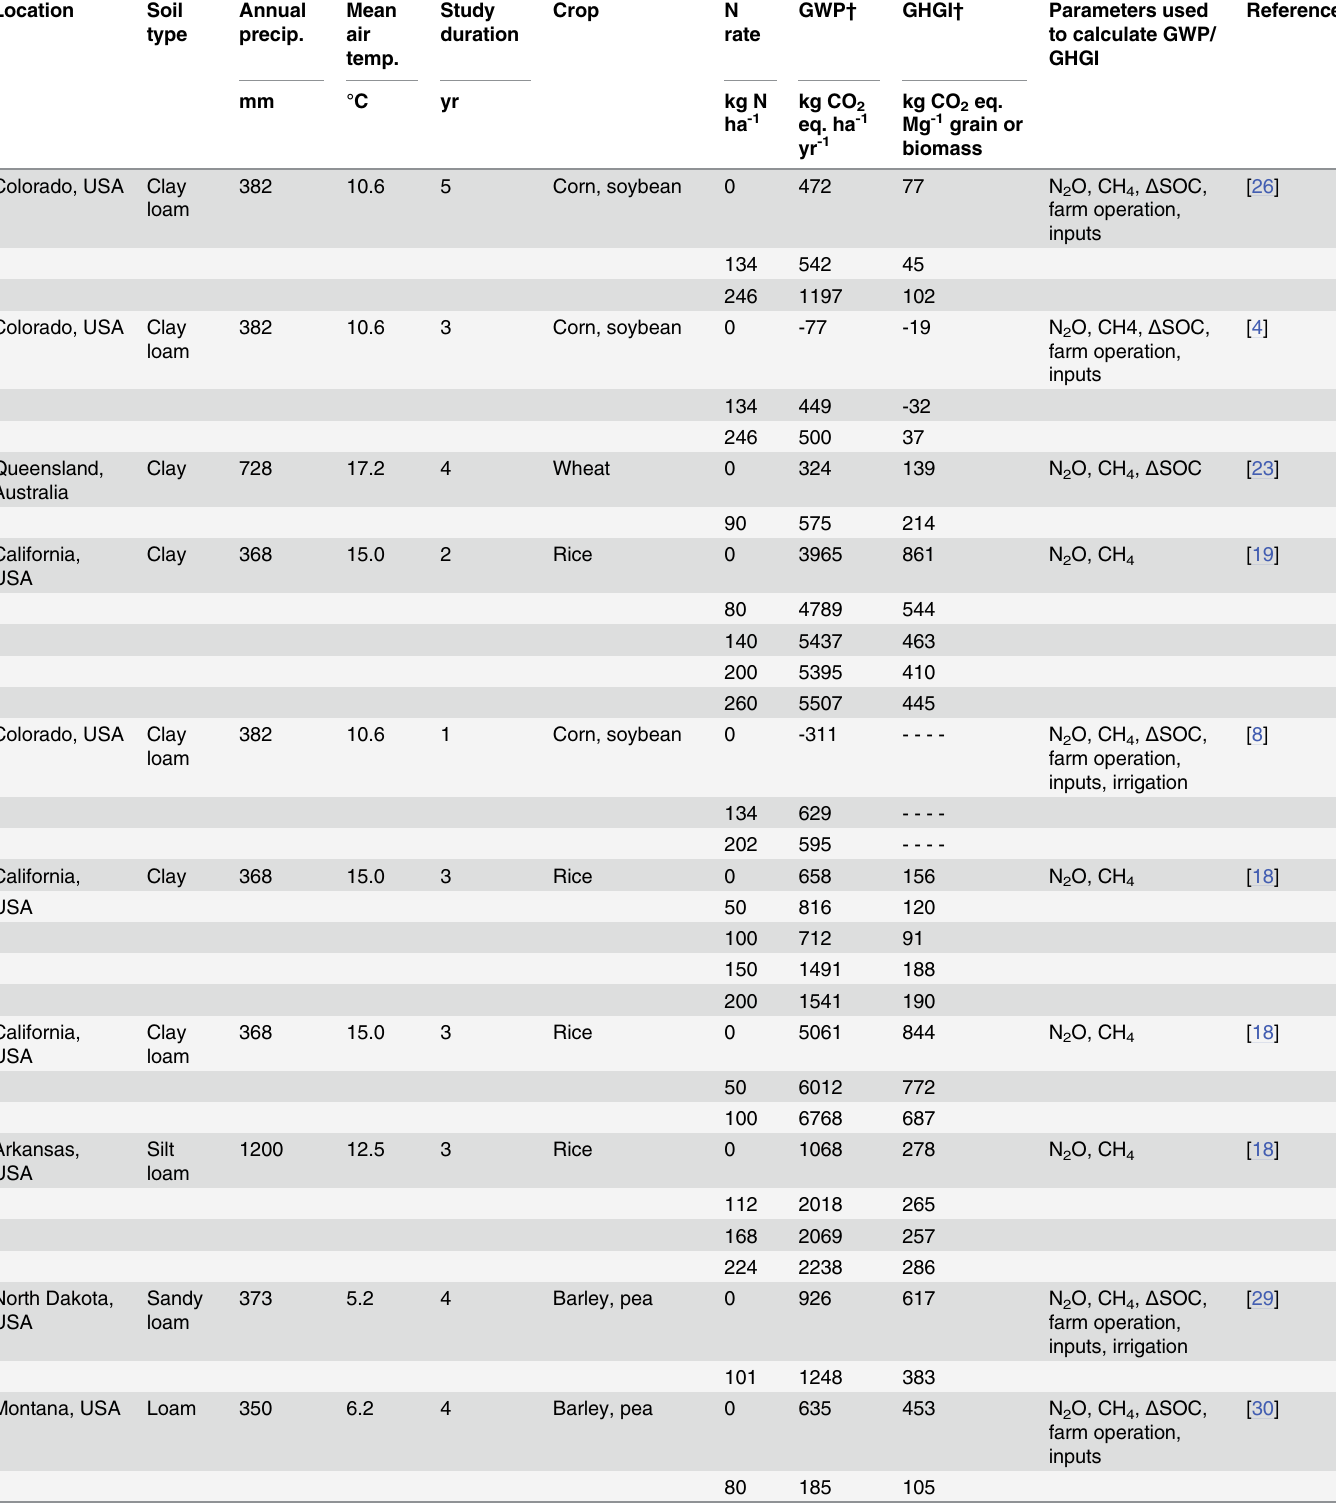
Table 3. Effect of N fertilization rate on net global warming potential (GWP) and greenhouse gas intensity (GHGI) calculated by using the soil organic C method in various regions with different soil and climatic conditions.